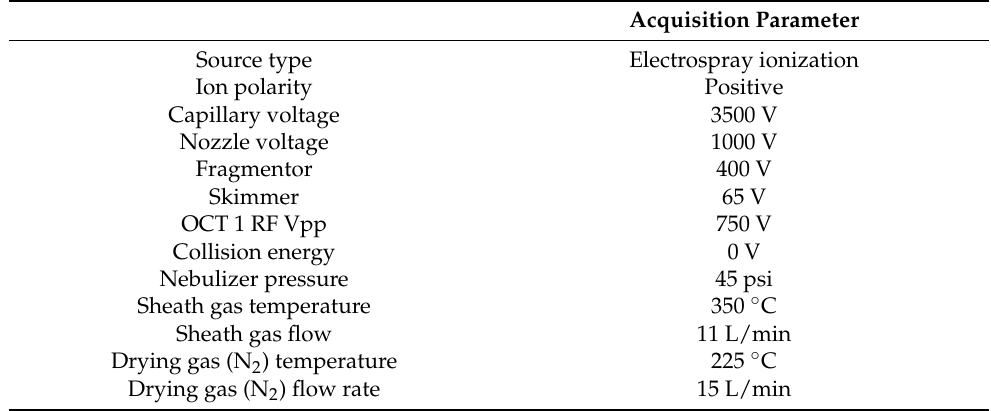
Table 3. Analytical conditions of the liquid chromatography quadrupole time-of-flight mass spec- trometry (LC-Q-TOF-MS)